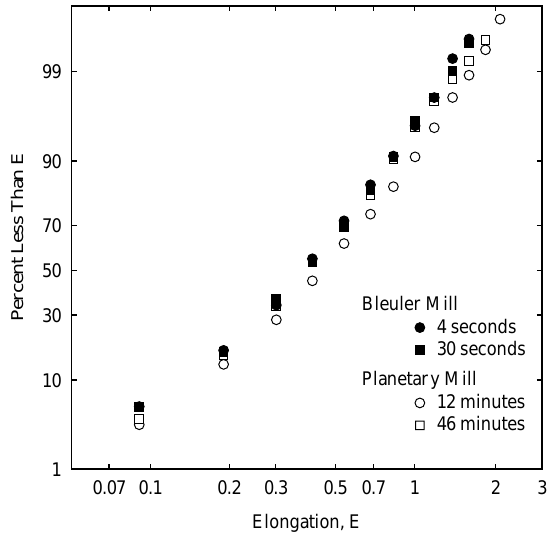
Fig. 4 Number distributions of elongation for coal particles (200 (cid:7) 270 US mesh) produced in both the Bleuler and planetary mills using different grinding